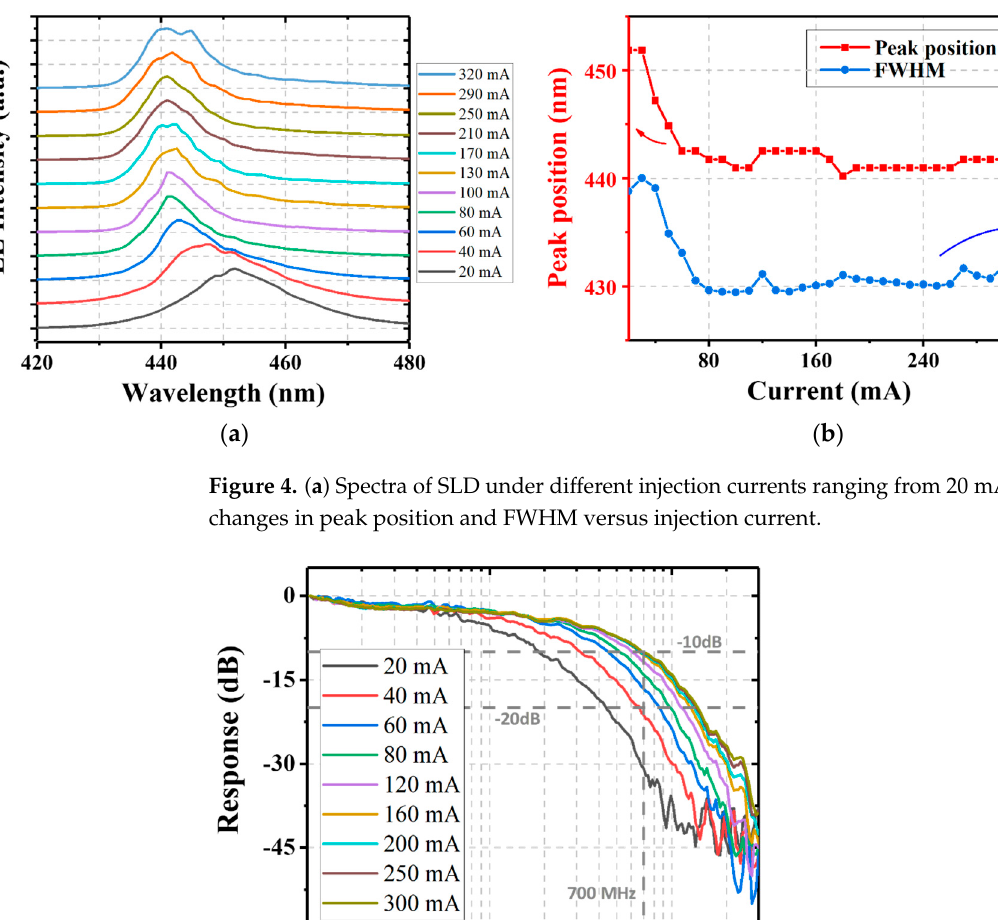
Figure 4. ( a ) Spectra of SLD under different injection currents ranging from 20 mA to 320 mA; ( b ) the changes in peak position and FWHM versus injection current.